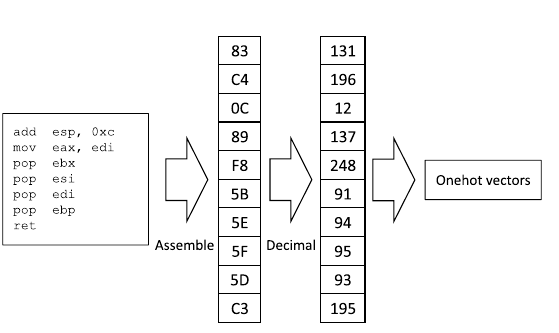
Fig. 5 Input data representation